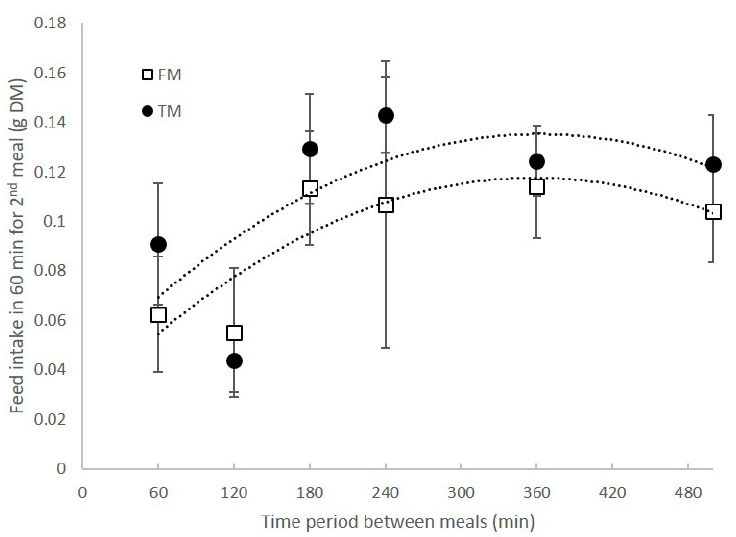
Figure 2. Revival of appetite in shrimp, expressed as the amount of feed consumed in the second meal, with different periods between meals. No significant difference in feed intake was observed between the two diets subjected to various immersion times (Figure 3; F = 0.95, p > 0.05). A consistent trend for a higher feed intake on TM was observed in this experiment but the response was not significant. Figure 3. Feed intake over 60 min for shrimp fed diets that had been leached in situ for various times prior to feeding.